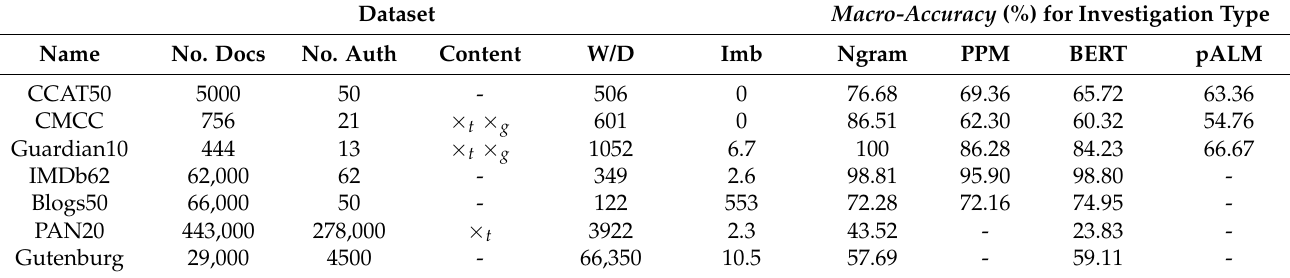
Table 2. State of the art macro-accuracy of authorship attribution models. Information collected from [10] (Tables 1 and 3). Name is the name of the dataset; No. docs represents the number of documents in that dataset; No. auth represents the number of authors; Content indicates whether the documents are cross-topic ( × t ) or cross-genre ( × g ); W/D stands for words per document , representing the average length of documents; imb represents the imbalance of the dataset measured by the standard deviation of the number of documents per